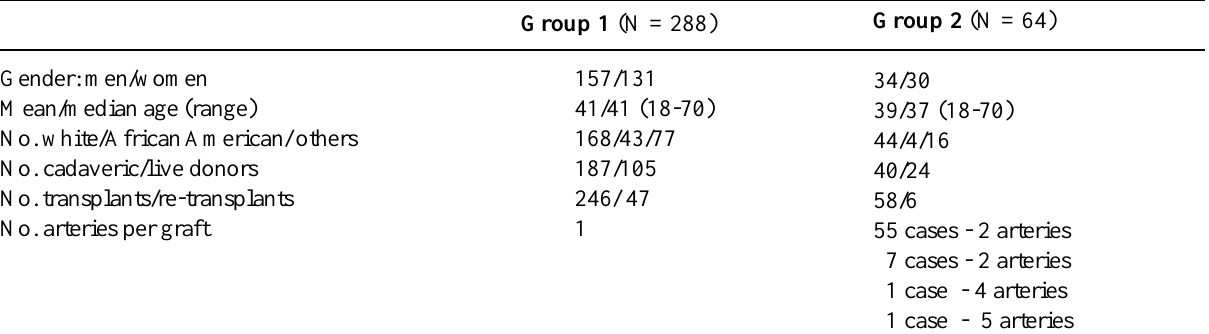
Table 1 – Demographic data and patients’ characteristics of group 1 (single renal artery) and group 2 (multiple renal arteries).